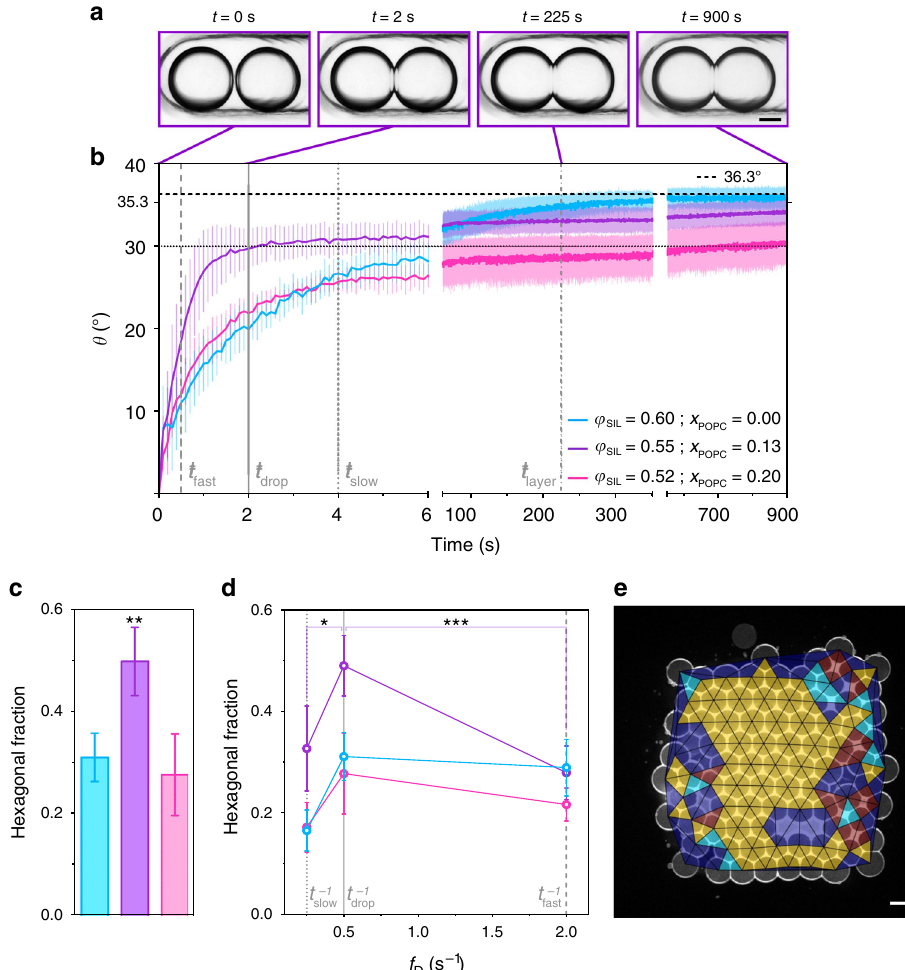
Fig. 3 The kinetics of contact angle equilibration affects hexagonal packing. For all conditions in a – e , θ DIB = 36.3° (calculated from Eq. (1)). The φ SIL and x – d are φ = 0.60 and x = 0.00 (cyan), φ = 0.55 and x = 0.13 (purple), and φ = 0.52 and x = 0.20 (magenta). a Optical POPC values in b SIL POPC SIL POPC SIL POPC microscopy images of two droplets (75 nL) forming a DIB after contact. The non-equilibrium contact angle ( θ ) increases with time (0 – 900 s) until the equilibrium contact angle ( θ DIB ) is reached ( t = 1800 s). Scale bar = 150 µ m. The images correspond to timepoints along the purple pro fi le in b . b Plots of θ versus time for droplet pairs. Plots are the mean of n = 5 repeats for each condition, and error bars represent the standard deviation. The grey dashed lines correspond to timepoints relevant to printing 3D droplet networks: t fast (0.50 s), t drop (2.00 s) and t slow (4.00 s) indicate the time intervals between consecutive printed droplets at fast ( t fast − 1 = 2.00 s − 1 ), standard ( t drop − 1 = 0.50 s − 1 ), and slow ( t slow − 1 = 0.25 s − 1 ) printing frequencies; t layer (225 s) is the time it takes to print a single layer at a printing frequency of 0.50 s − 1 . c A bar chart of the hexagonal packing area fraction of 3D droplet networks printed at a droplet ejection frequency of 0.50 s − 1 . The hexagonal area fraction under the purple condition was signi fi cantly greater than for the other two conditions (one-way ANOVA with Tukey ’ s multiple comparison test) (see Supplementary Table 15). d Plots of hexagonal packing area fractions in the fi rst layers of 3D droplet networks generated at different printing frequencies ( f D ). The frequencies marked in grey are the inverse of the timepoints marked in b (i.e., − 1 , where t f = t D D D is the time interval between the ejection of two consecutive droplets). For statistical tests, see Supplementary Table 16. e A confocal microscopy image and overlay of Delaunay triangulation of the fi rst layer in a 3D-printed droplet network (7 × 8 × 4; x , y , z ) at φ SIL = 0.55 and x POPC = 0.13 (purple condition in b – d ) at a printing frequency of 0.50 s − 1 . Scale bar = 100 µ m. Each data point in the graphs c and d is the mean of n > 3 repeats, and error bars represent the standard deviation. *, ** and *** indicate p -value <0.05, 0.01 and 0.001, respectively. For individual n values, see Supplementary Tables 22 and